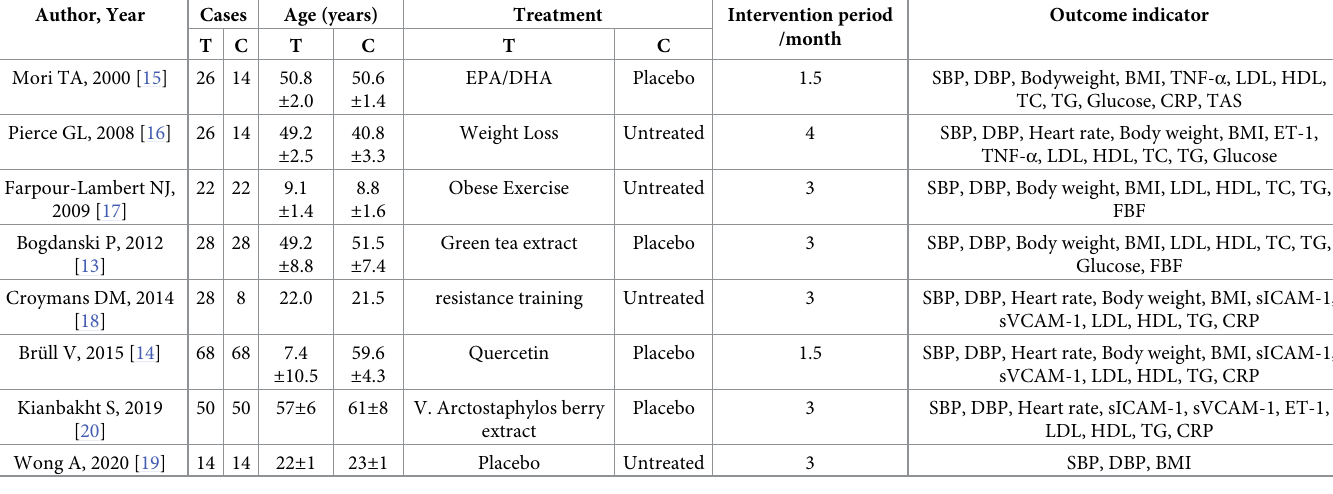
Primary outcome measures. (I) Subgroup analysis based on life-style and dietary supple- ments showed that improvements in SBP were observed in 43.7% of cases with lifestyle changes Table 1. Basic information of the included